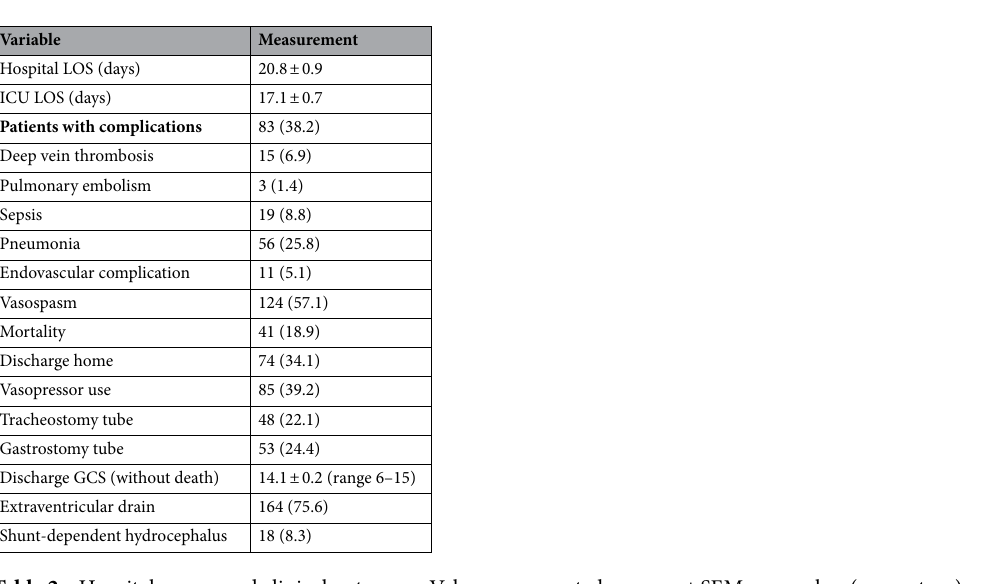
Table 2. Hospital course and clinical outcomes. Values are reported as mean ± SEM or number (percentage). LOS length of stay, ICU intensive care unit, GCS Glasgow Coma Scale score.